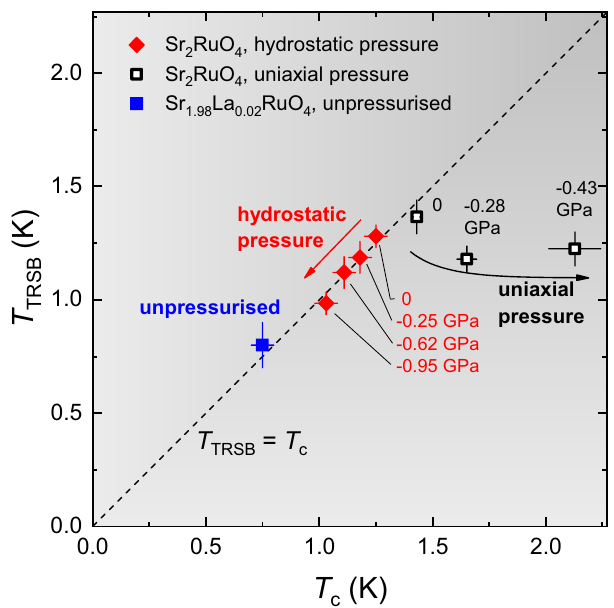
Fig. 4 Relation between T TRSB and T c . Dependence of the time reversal symmetry breaking temperature T TRSB on the superconducting transition temperature T c . The closed symbols correspond to the results obtained in present studies under hydrostatic pressure up to 0.95 GPa in pure Sr 2 RuO 4 (diamonds) and in the La-doped Sr 2 − y La y RuO 4 with T c = 0.75(5) K (square). The open squares are the uniaxial pressure data for undoped Sr 2 RuO 4 from ref. 47 . The dashed line corresponds to T TRSB = T c . The minus signs at the pressure values denote the effect of ‘ compression' of the sample volume. The error bars are the same as de fi ned in Figs. 2 and 3 and in ref. 47